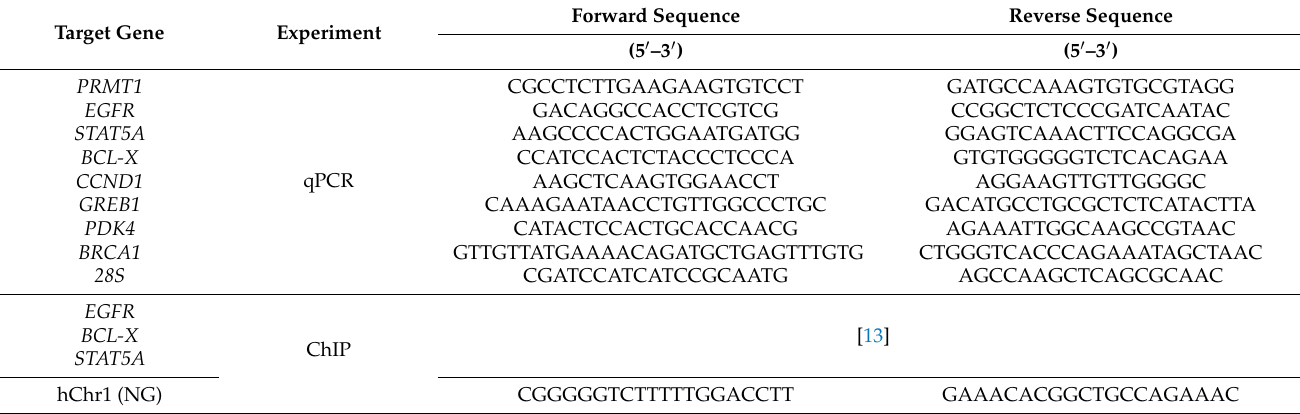
Table 2. List of primers used in this study. qPCR: quantitative polymerase chain reaction; ChIP: chromatin